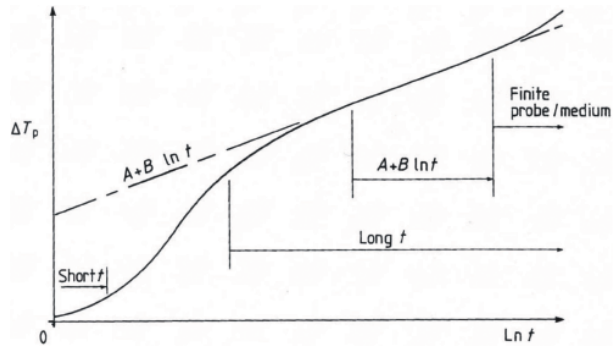
Fig. 6. Qualitative heating curve measured with a line heat sensor (after Jones,